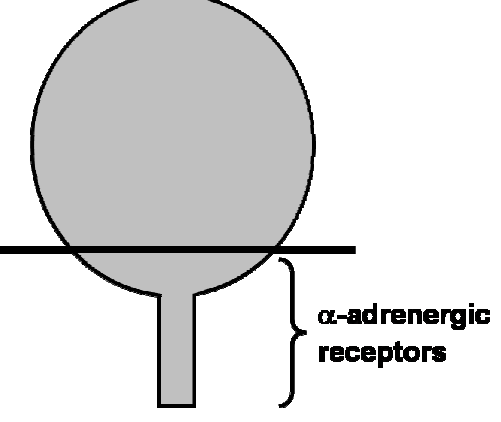
FIGURE 1 . Location of alpha-adrenergic receptors in the